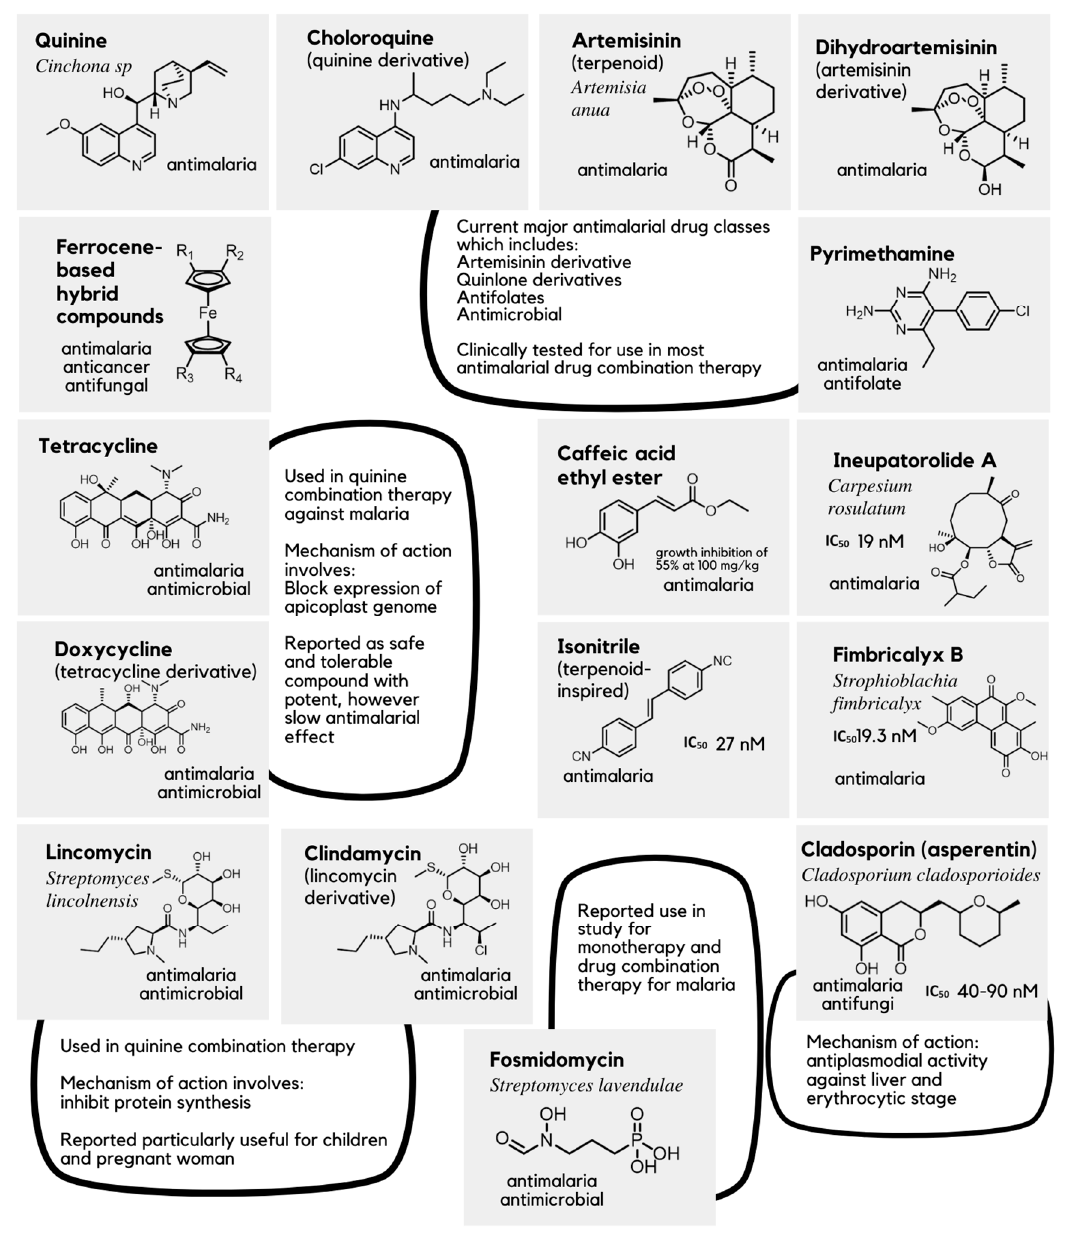
Figure 2. Currently available drugs and biologically active compounds used in the research for treatment of malaria. [2,3,8,9].